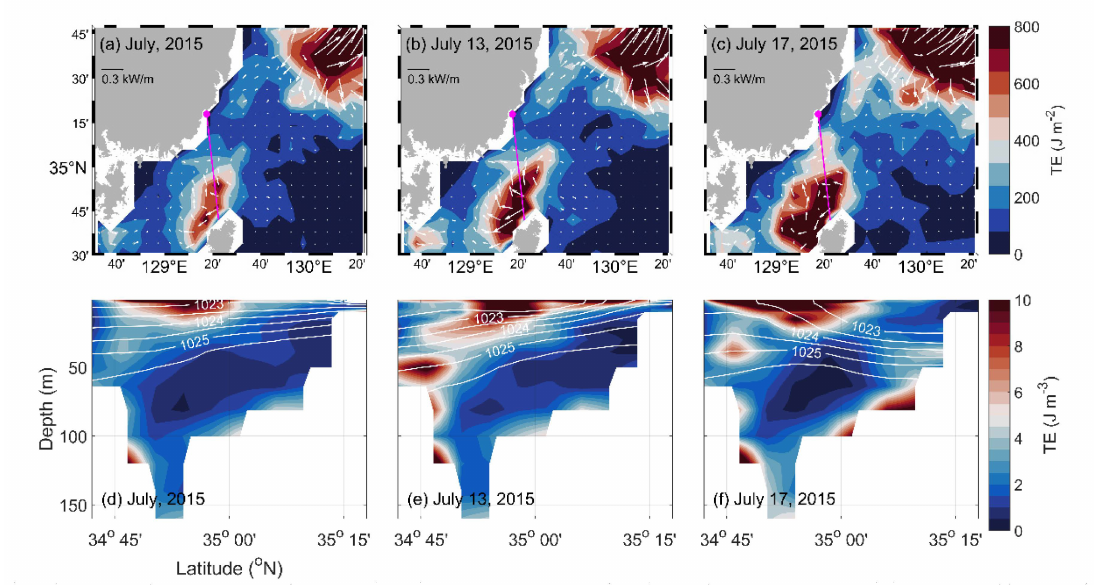
Figure 7. Average depth-integrated total energy (TE) and depth-integrated horizontal energy flux ( EF ) (arrows) for semidiurnal internal tides ( a ) in July, ( b ) on 13 July, and ( c ) on 17 July 2015; the vertical section of the average TE and density (white contour) ( d ) in July, ( e ) on 13 July, and ( f ) on 17 July 2015, along the magenta line in ( a – c